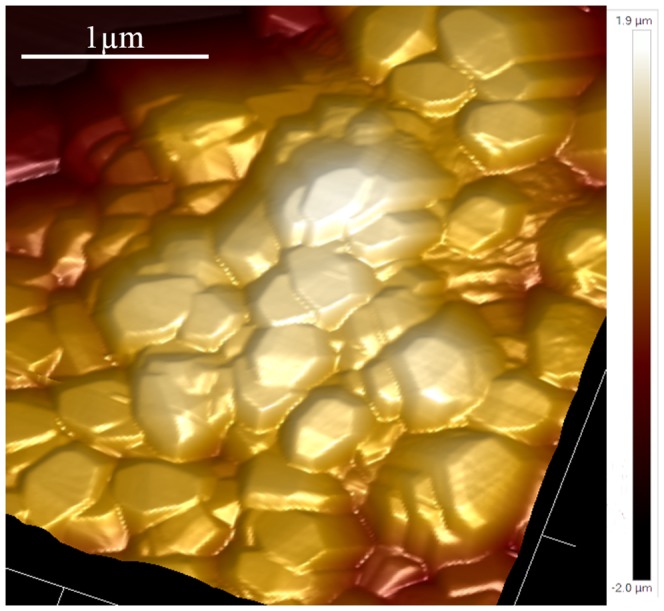
AFM 3D reconstruction of the morphology of NNS BaTiO3.